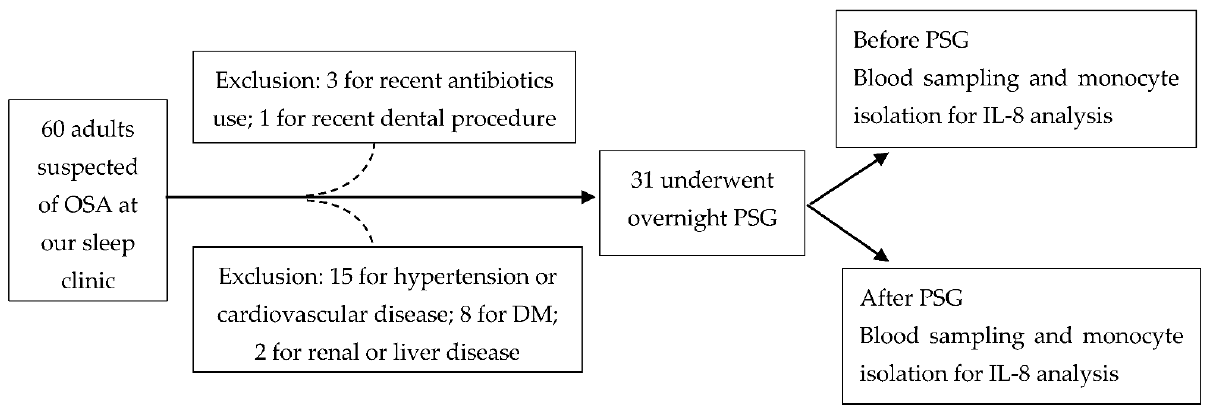
Figure 5. The flow chart of our patients’ selection and study protocol. Abbreviations: DM = diabetes mellitus; IL = interleukin; OSA: obstructive sleep apnea; PSG: polysomnography.